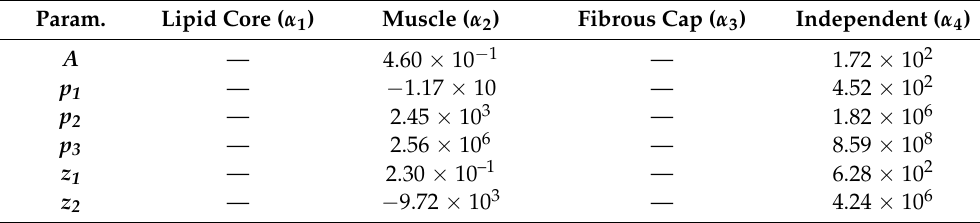
Table 3. Coefficients for Equation (9) in configurations without neo-atherosclerosis. Param.